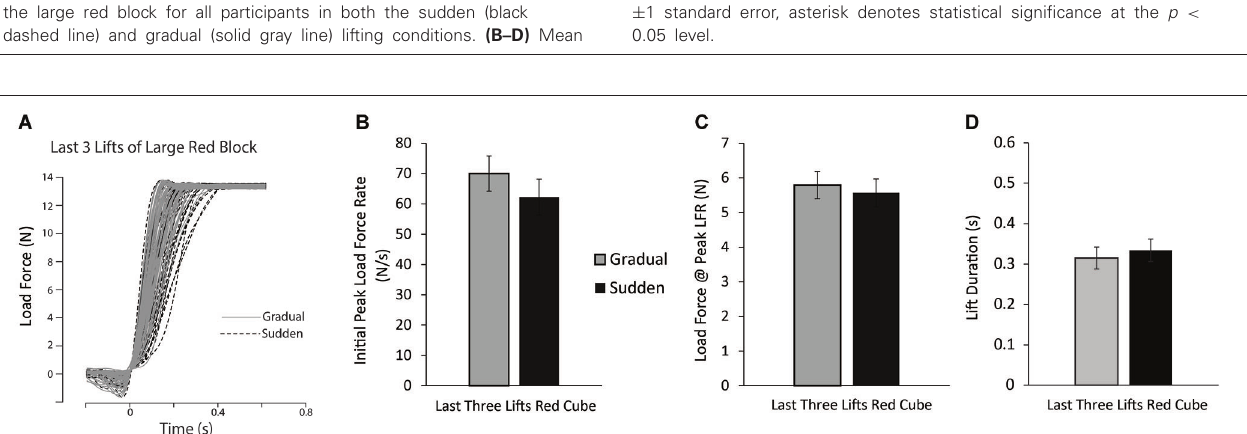
FIGURE 4 | Lift performance on last lifts of large red block. (A) Load force records as a function of time from the last three lifts of the large red block for all participants in both the sudden (black dashed line) and gradual (solid gray